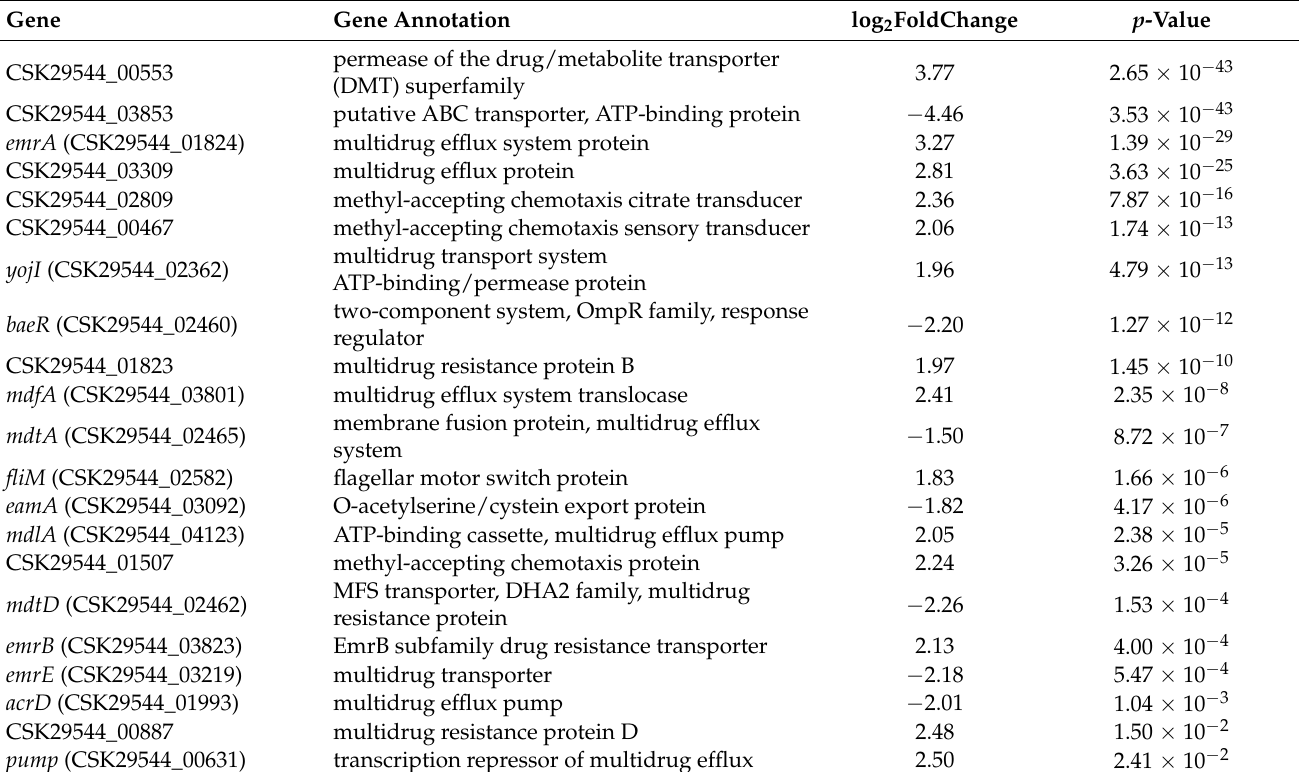
Table 5. Drug resistance-related differentially expressed